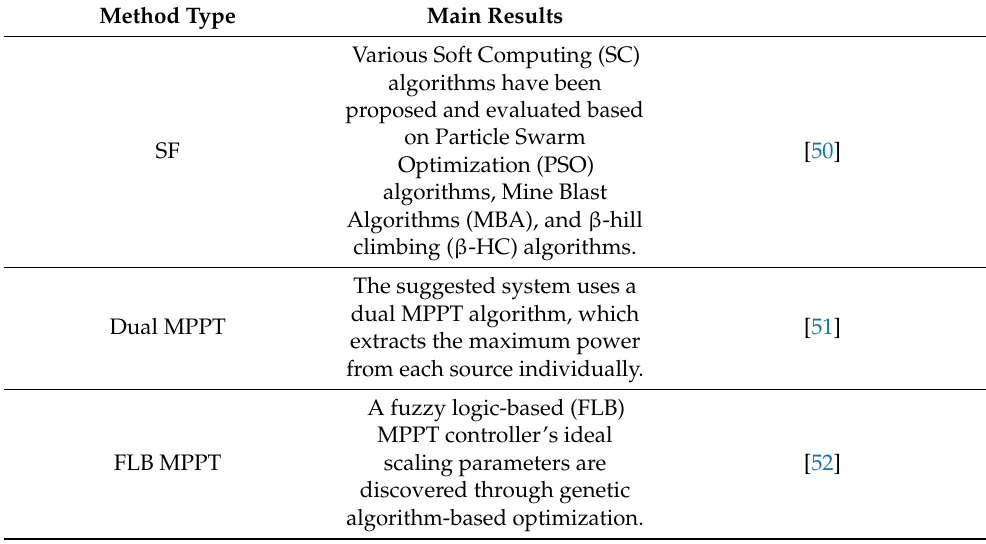
Table 5. Application of different MPPT methods for pumping systems.